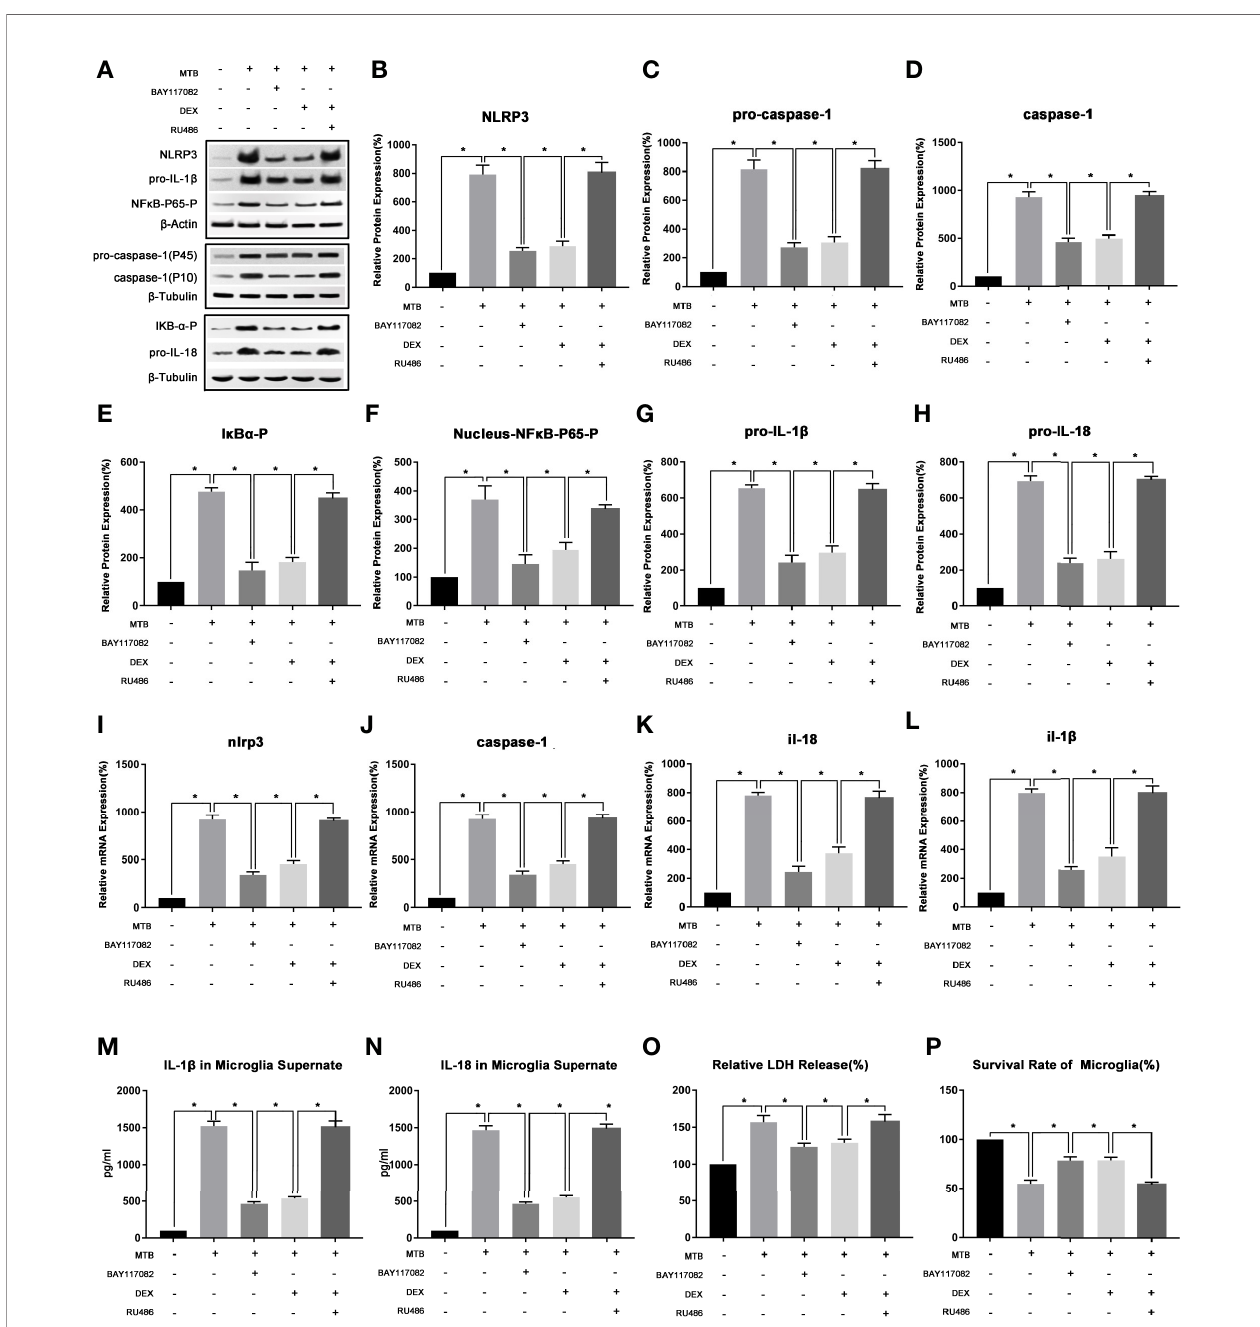
FIGURE 3 | The changes of NF- k B pathway and its intervention factors during the activation of NLRP3 in fl ammasome in microglia. (A – H) Use Western Blot to detect the relative protein expression of NLRP3, pro-caspase-1, caspase-1, pro-IL-1 b and pro-IL-18, phosphorylated I k B- a and phosphorylated NF- k B-P65 in control group, co-culture group, BAY-11-7082 group, DEX group and RU486+DEX group. (I – L) Use Real-time PCR to detect the relative mRNA expression of nlrp3, caspase-1, il-1 b and il-18 in control group, co-culture group, BAY-11-7082 group, DEX group and RU486+DEX group. (M, N) Use ELISA to detect the IL-1 b and IL-18 secretion in supernatant of control group, co-culture group, BAY-11-7082 group, DEX group and RU486+DEX group. (O) Use LDH release to measure the cytotoxicity in control group, co-culture group, BAY-11-7082 group, DEX group and RU486+DEX group. (P) Use MTT analysis to detect the cell survival rate in control group, co-culture group, BAY-11-7082 group, DEX group and RU486+DEX group. *P <